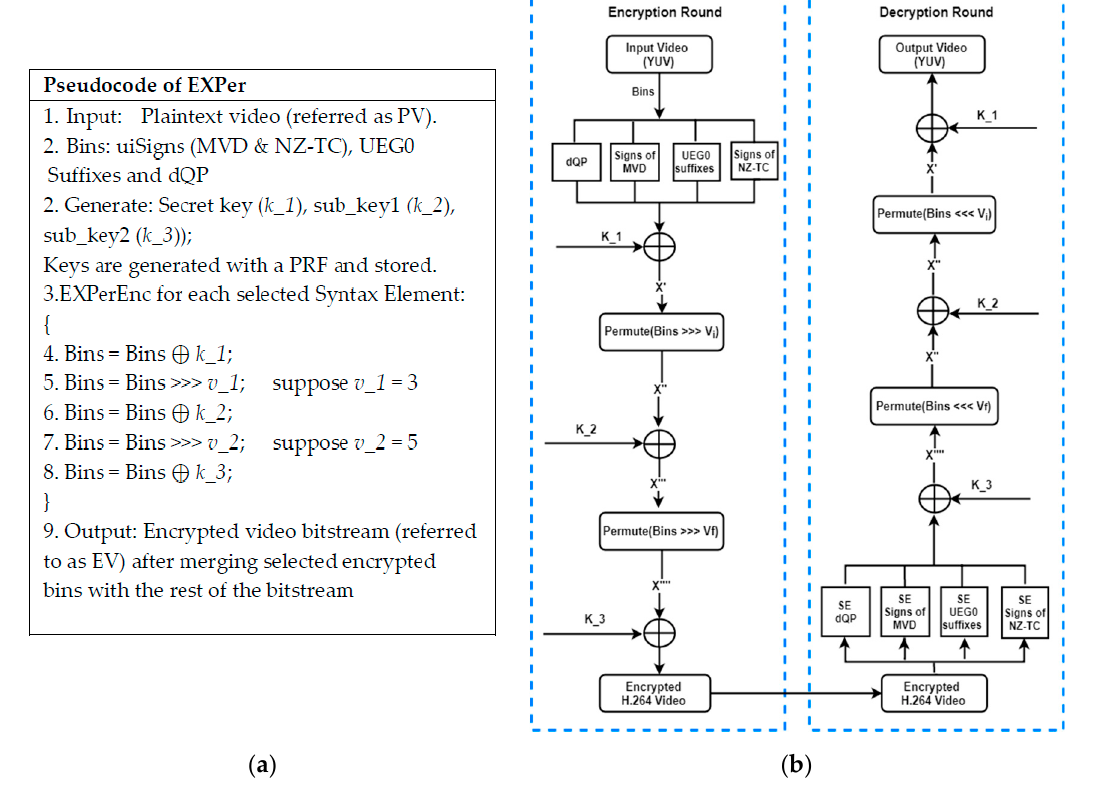
Figure 3. (a) Pseudo-code and (b) graphical flow of EXPer cipher. Figure 3. ( a ) Pseudo-code and ( b ) graphical flow of EXPer